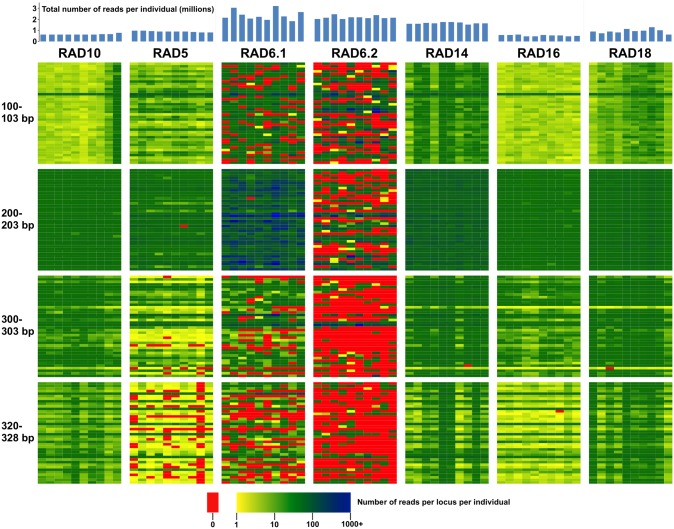
Recovery of indigobird ddRAD loci across individual samples and sequencing runs.Sequencing depth for 160 selected loci (rows), including 40 loci in each of four narrow size ranges, is shown for 10 randomly selected samples (columns) from each of seven pooled libraries. The 160 loci illustrated are a subset of the 5,996 loci recovered in all 46 indigobirds sequenced in the RAD10 sequencing run. Overall sequencing depth for each individual sample is show in the bar graph at top. Sequencing depth for each locus is indicated by color (see scale at bottom of figure), with red indicating no data. See text for more information.